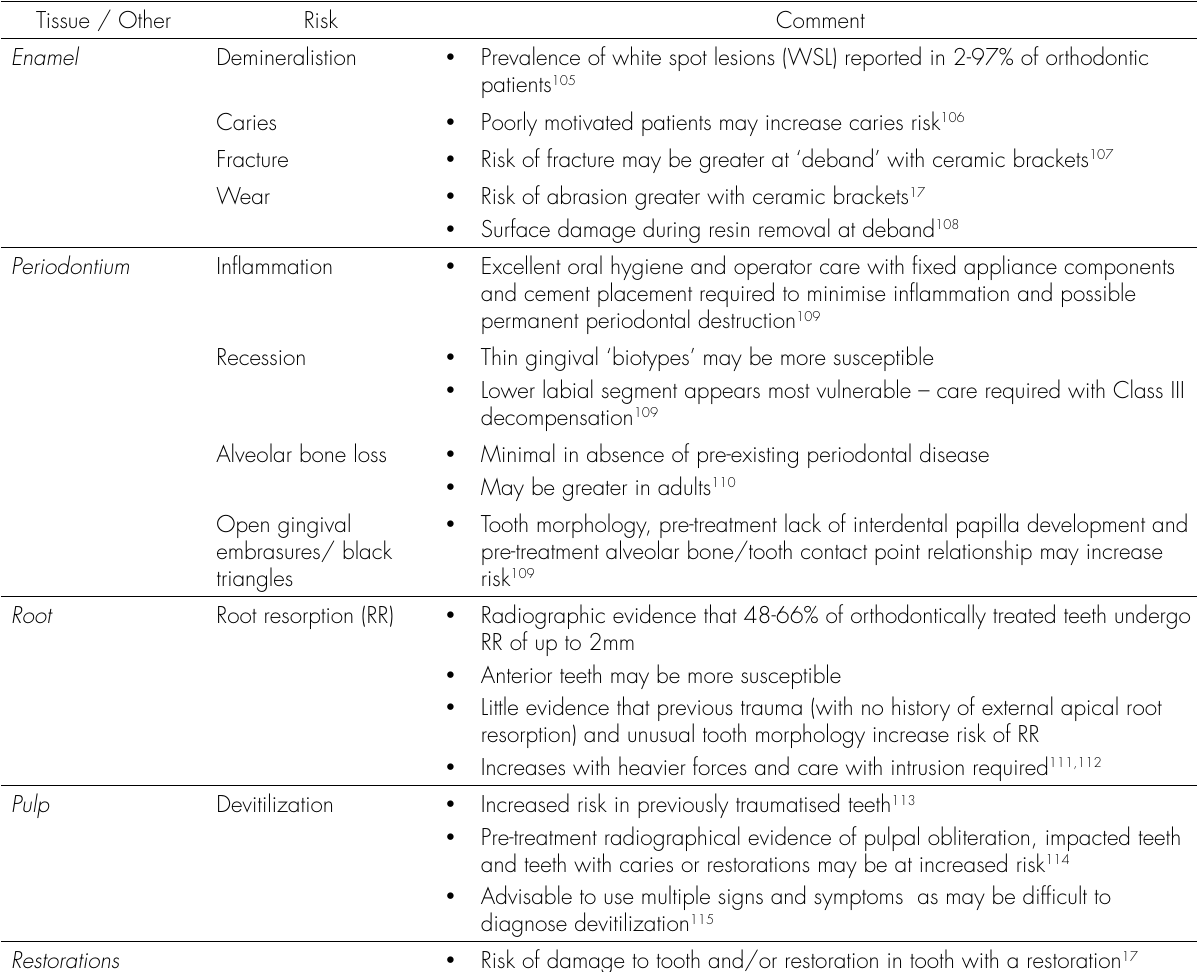
Table III. Summary of the main proposed intraoral risks of orthodontic